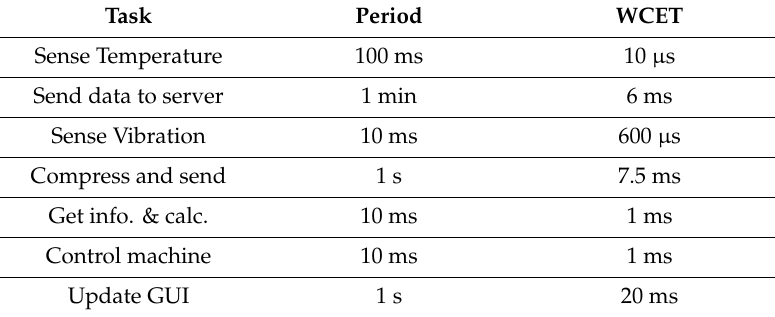
Table 3. Internet-of-things (IoT) task set parameters. WCET = worst case execution time; GUI = graphical user interface.